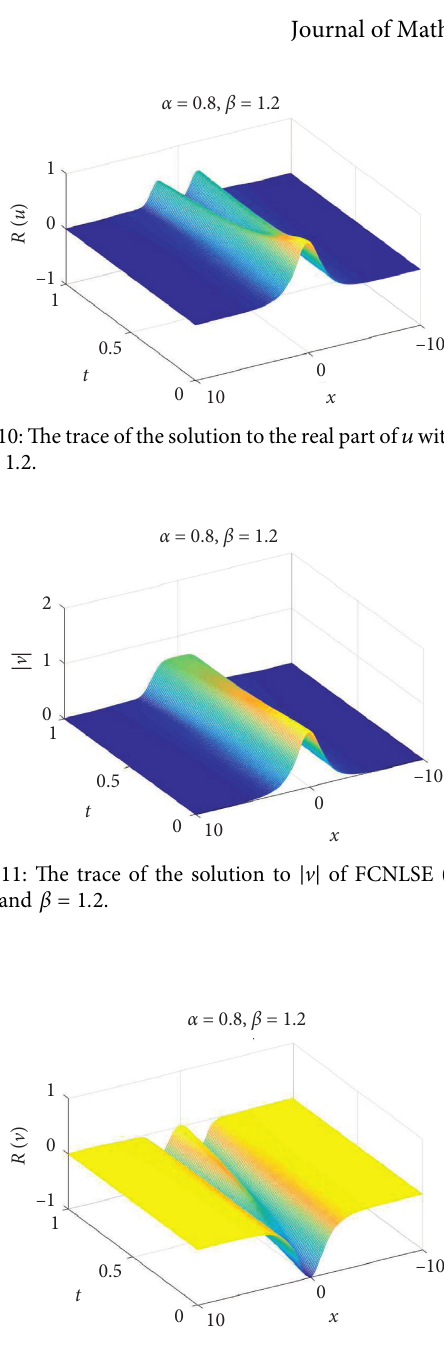
Figure 12: The trace of the solution to the real part of v with α � 0 . 8 and β � 1 . 2.